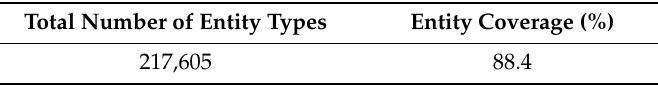
Table 8. Entity statistics for the initial annotated